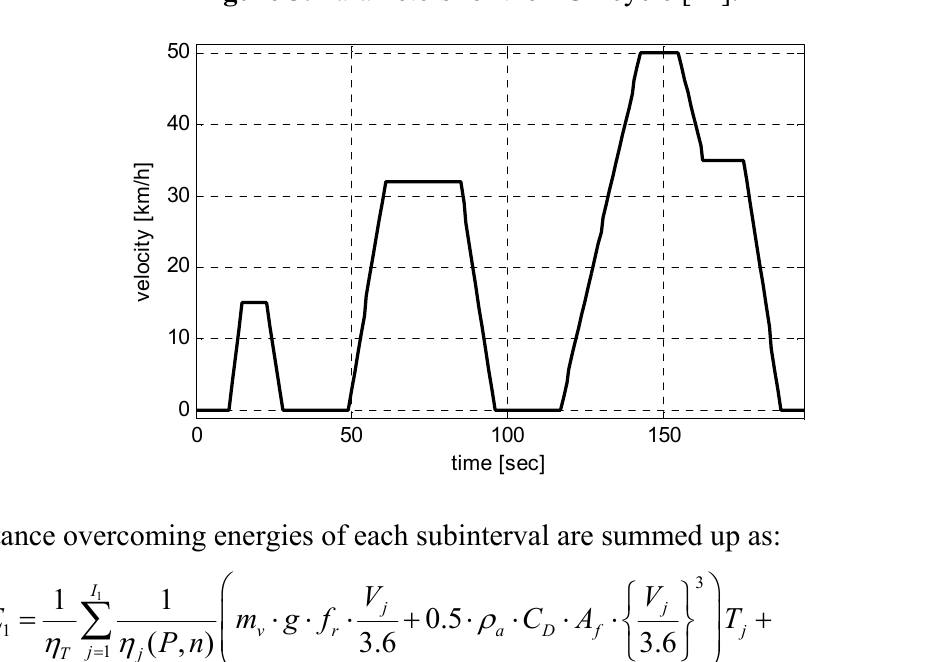
Figure 3. Parameters for the ECE cycle